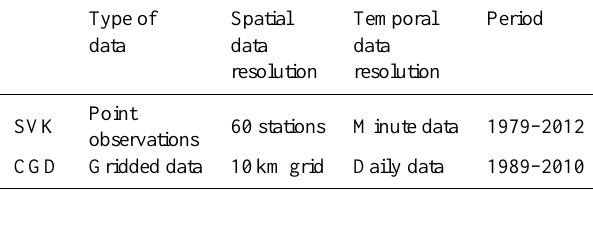
Table 1. Main characteristics of the two observational data sets used in this study.